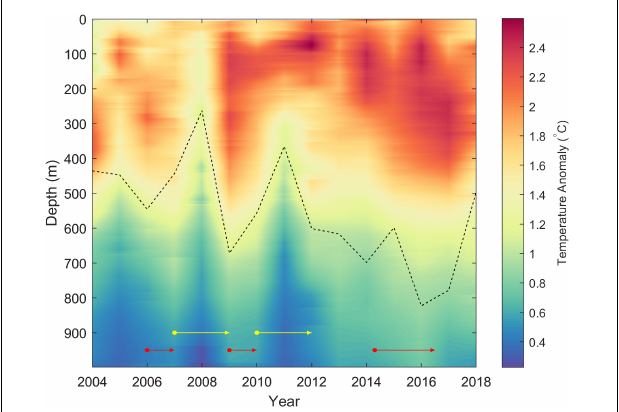
FIGURE 14 | Yearly composite of temperature anomaly in MHWs. The annual mean of MHW depth (thick black line) is overlaid. Arrows indicating major El Niño (red) and La Niña (yellow) events are shown. ENSO events are identified using SOI monthly (BOM) where maxima exceed ±